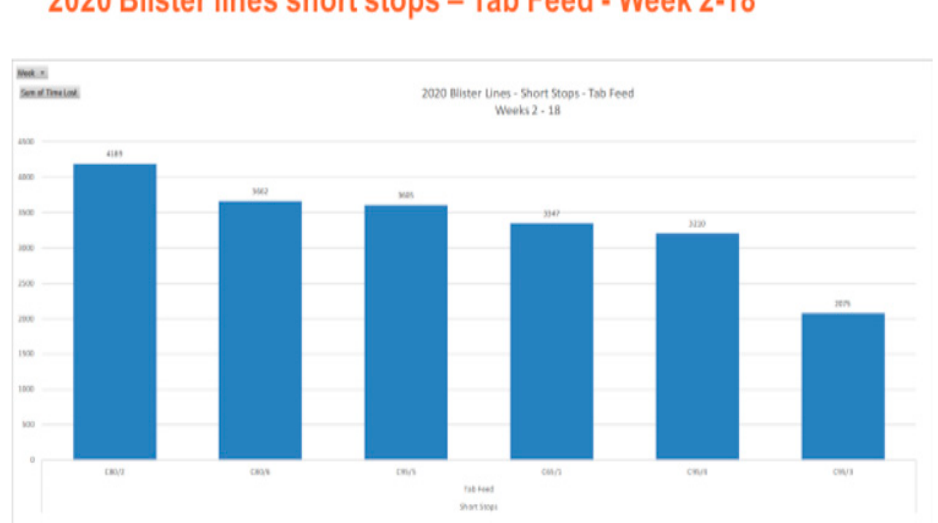
Figure 5. Number of incidences of blister lines short stops as a result of tablet feed issues measured across six production lines (with quantity of short stop issues on the y-axis and the line number (line type) on the x-axis) measured over a 16-week period.